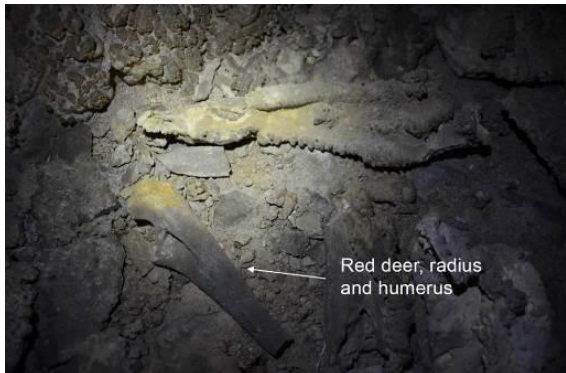
Figure 1. Some macromammals remains on the cave